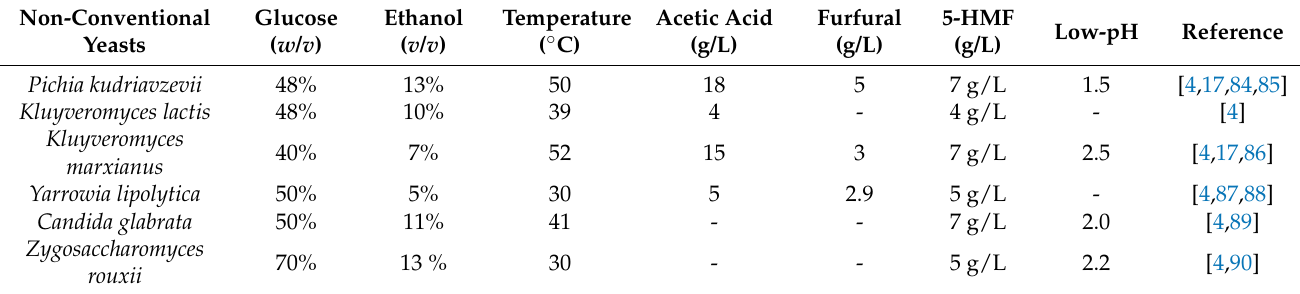
Table 1. Overview industrially relevant phenotypes of P. kudriavzevii and other well-studied non- conventional